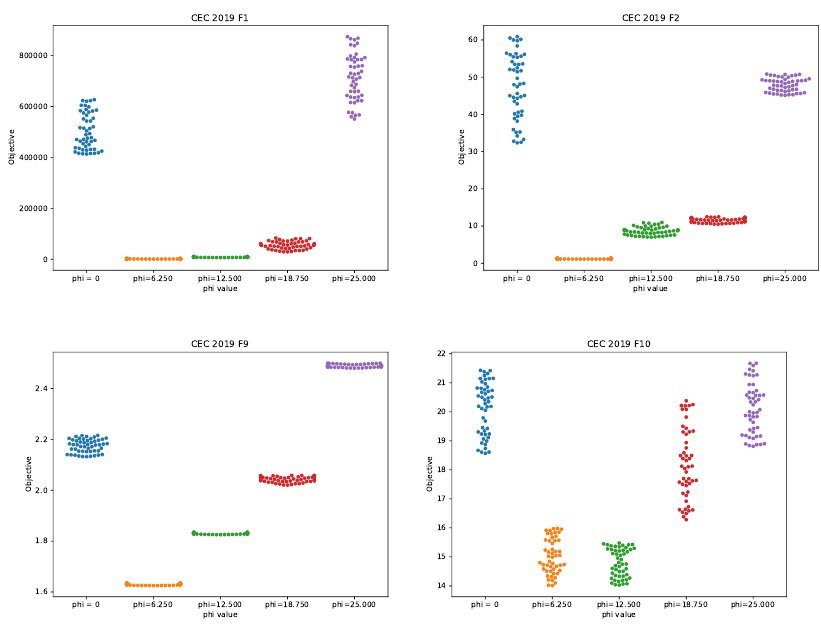
Figure 2. The eHHO swarm plots for CEC01, CEC02, CEC09 and CEC10 benchmarks with varying ψ